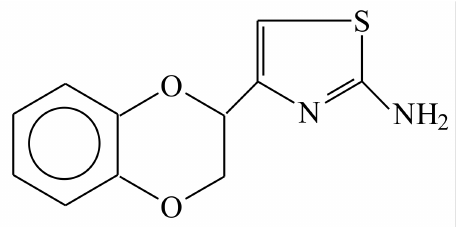
Figure 1. Chemical structure of 2-(2-amino-4-thiazolyl)-1,4-benzodioxane hydrochloride (beditin), a new benzodioxane